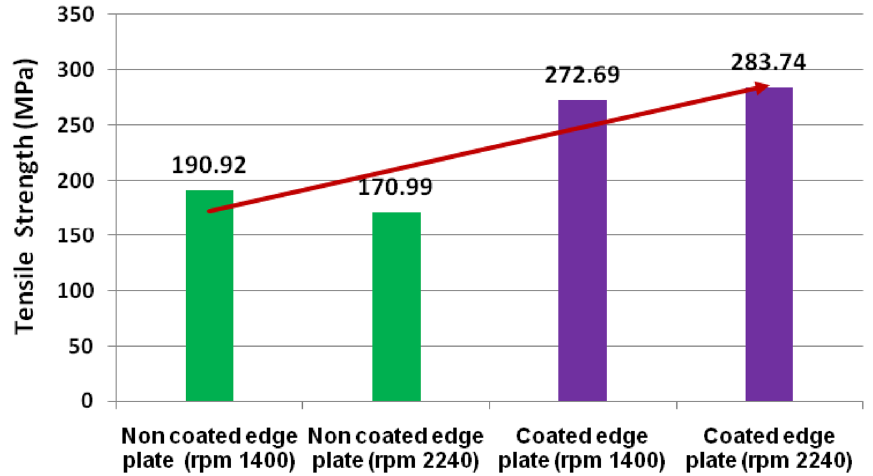
Figure 10. Tensile strength of FSW joints at varying rpm.